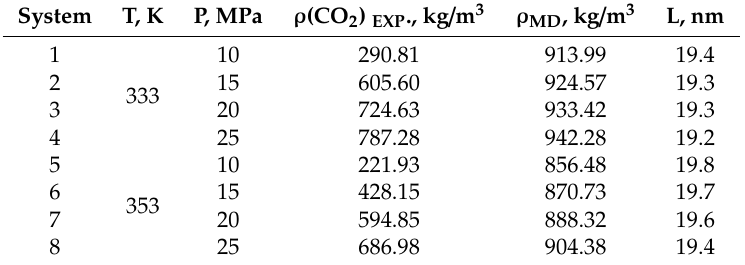
Table 2. Stated parameters of the simulated systems: Temperature T, Pressure P, experimental Density of CO 2 ρ (CO 2 ) EXP [50], total Density of the systems at the end of simulation ρ MD , and size of cubic cell